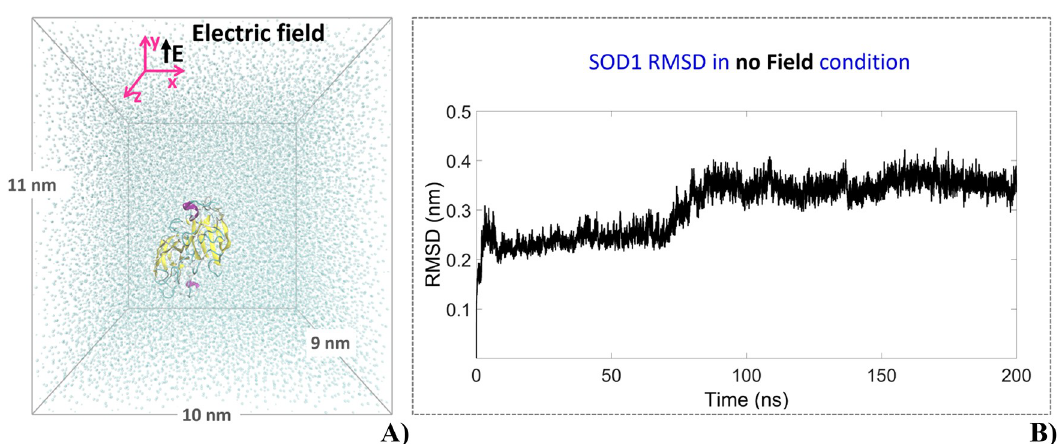
Fig 1. SOD1 molecular model. (A) SOD,Cu-Zn molecular model showing the simulation box (10 x 11 x 9 nm 3 ) containing 32292 water molecules, the SOD1 enzyme and 9 Na + counterions. The SOD,Cu-Zn enzyme is formed by two monomers, each one containing a reaction centre. The electric field is applied in the y direction; (B) RMSD of the SOD1 enzyme during equilibration of the 200 ns ‘no field’ production run.